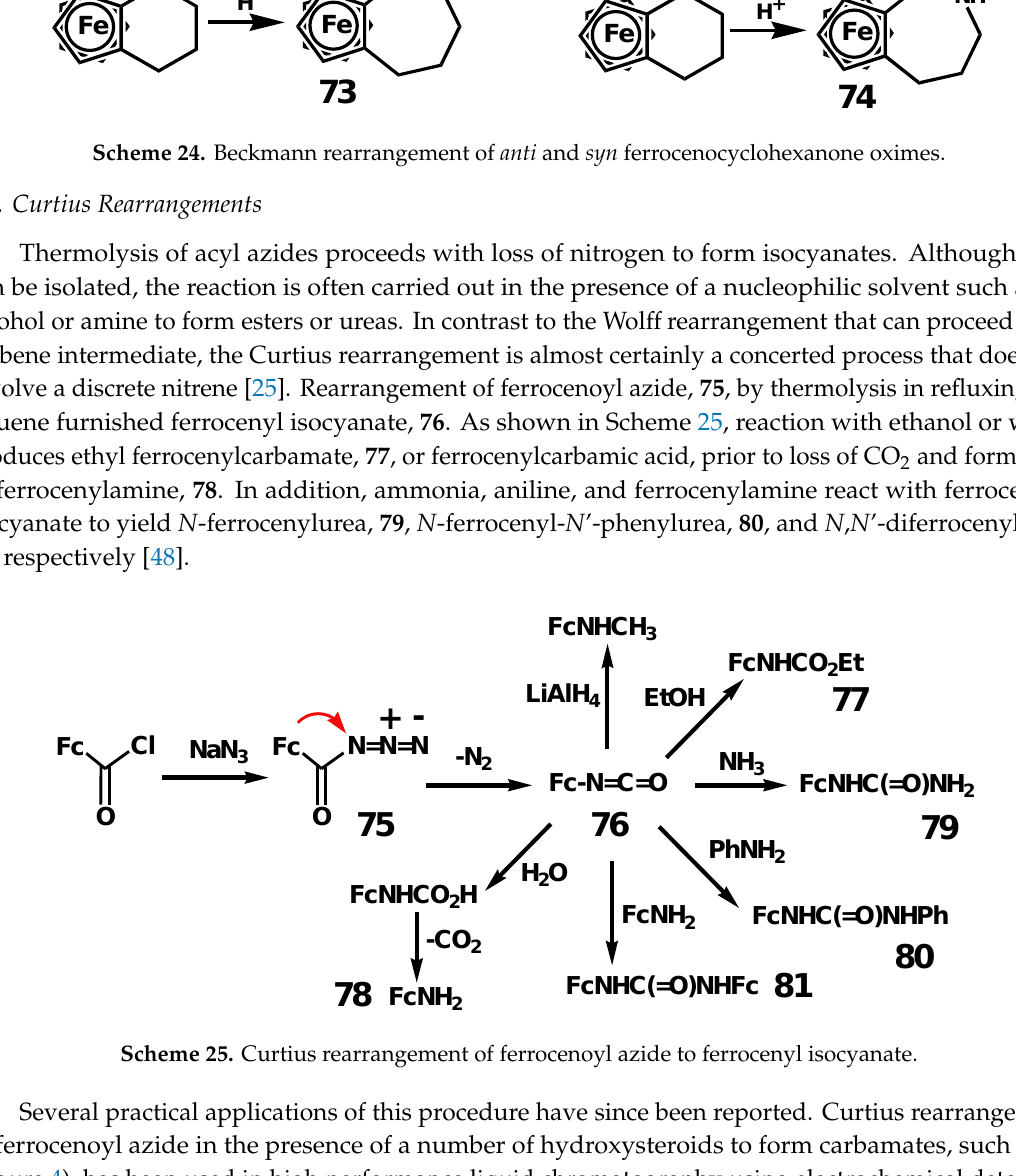
Figure 4. Steroidal and boronic acid ester carbamates derived by reaction of alcohols with ferrocenyl isocyanate. 5.3. Benzidine Rearrangement Protonation of hydrazobenzene, 84 , brings about cleavage of the HN–NH linkage and coupling of the phenyl substituents, normally in the para -positions to form 4,4’-diaminobiphenyl (benzidine), 85 . In the course of their pioneering studies of derivatives of ferrocene, the Nesmeyanov group attempted the benzidine rearrangement of hydrazoferrocene, 86 , but to no avail (Scheme 26). The major products arose from disproportionation to form azoferrocene, 87 , and ferrocenylamine [51]. When the ferrocenyl unit was instead incorporated as a substituent in hydrazobenzene, the major products upon treatment with HCl were ferrocenylazobenzene, ferrocenylaniline, and aniline, again resulting from disproportionation rather than rearrangement